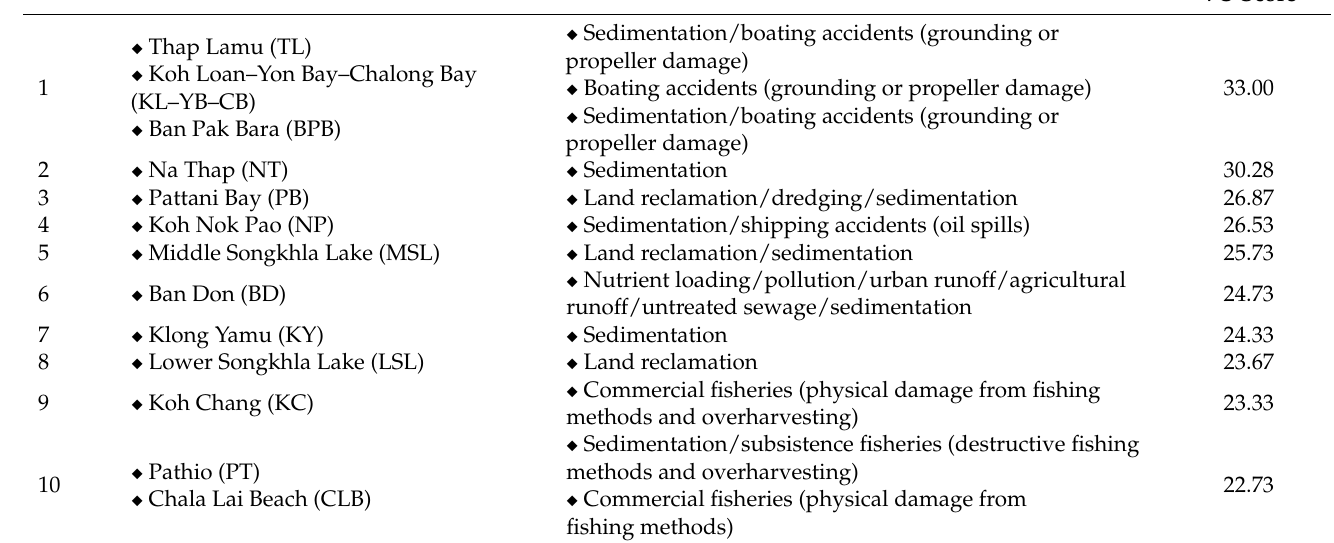
Table 2. Ten highest final VU scores (13 sites) from 82 seagrass sites across Thailand; information is provided together with the most important threats of each site (1 = highest VU rank; 10 = 10th highest VU rank).